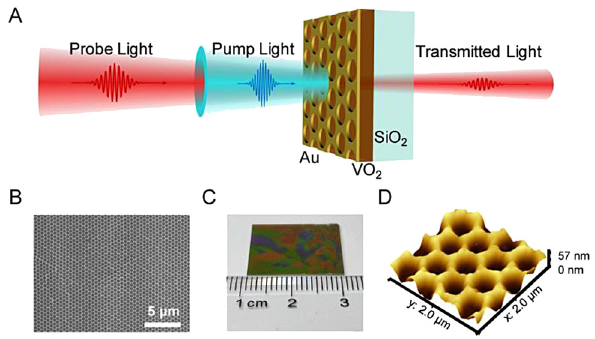
Figure 1: Design and fabrication of the Au/VO 2 active metasurfaces. (A) Sketch of the VO 2 -based active metasurface device. An 800-nm wavelength femtosecond pumplight (blue)is usedto triggertheIMT ofVO 2 ,whichisprobedataround2200nmwavelength.(B)Top-view SEM image of the metasurface showing a 20 × 15 μ m 2 size area. (C) Photograph of 2 × 2 cm 2 active metasurface sample. (D) AFM surface morphology of the Au/VO 2